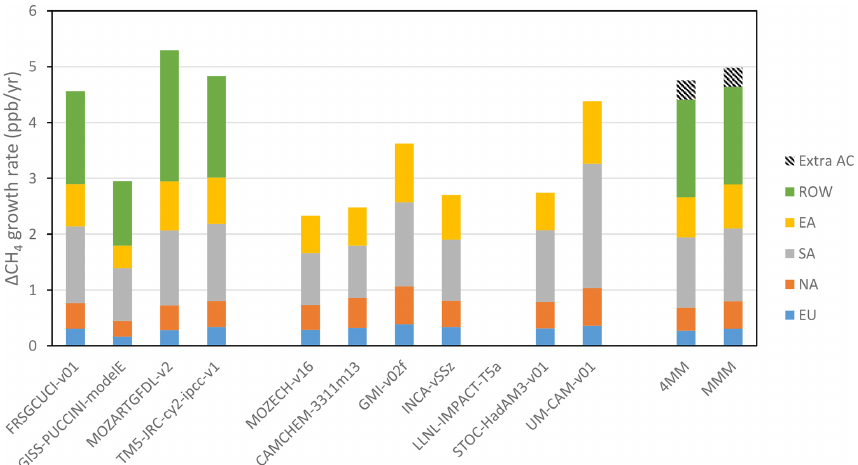
Figure 5. Calculated changes in the global methane growth rate from changes in anthropogenic NO x emissions during the 2020 lockdown for each of the HTAP models. Also shown are values for the mean of the four core models (shown on left) (4MM) that reported results for all simulations as well as multi-model mean (MMM) results based on all available models. The four core models included global experiments, allowing the calculation of ROW contributions. Regional contributions partially include aviation NO x ; a further contribution from aviation (Extra AC) is also shown for the multi-model results (see the text for details). Table 2. Summary of impacts on the 2020 global methane growth rate (ppbyr − 1 ) relative to 2019 due to COVID-19 lockdown emission reductions based on 4MM results. Values for total aviation NO x are given in parentheses, as they are already partly included in the regional values; the additional aviation component not included in the regional values (Aviation (extra)) is also shown. NO x CO NMVOCs Total EU 0.27 ± 0.07 − 0 . 13 ± 0.03 − 0 . 06 ± 0.05 0.08 ± 0.10 NA 0.41 ± 0.09 − 0 . 16 ± 0.04 − 0 . 03 ± 0.03 1.26 ±